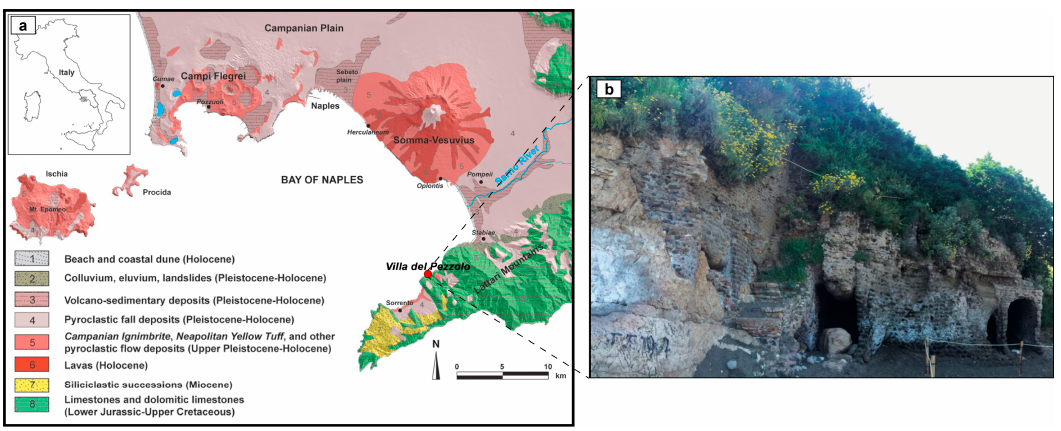
Figure 1. ( a ) Geological sketch map of Bay of Naples area (modified after [1]) with the location of the archaeological site Villa del Pezzolo ; ( b ) picture of Villa del Pezzolo.